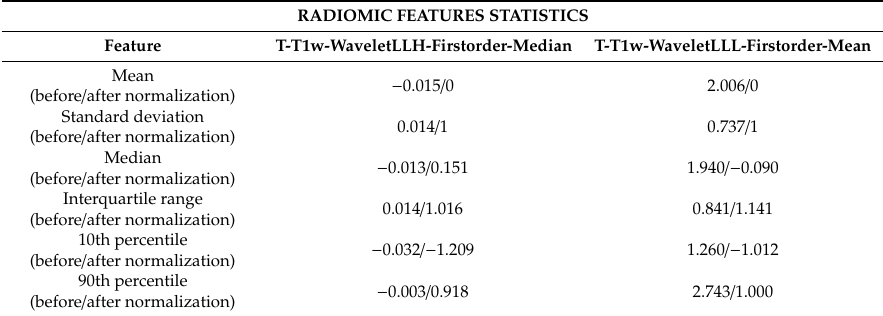
Table 3. Descriptive statistics for the two radiomic features used in the radiomic model. The values are shown up to the third decimal digit.